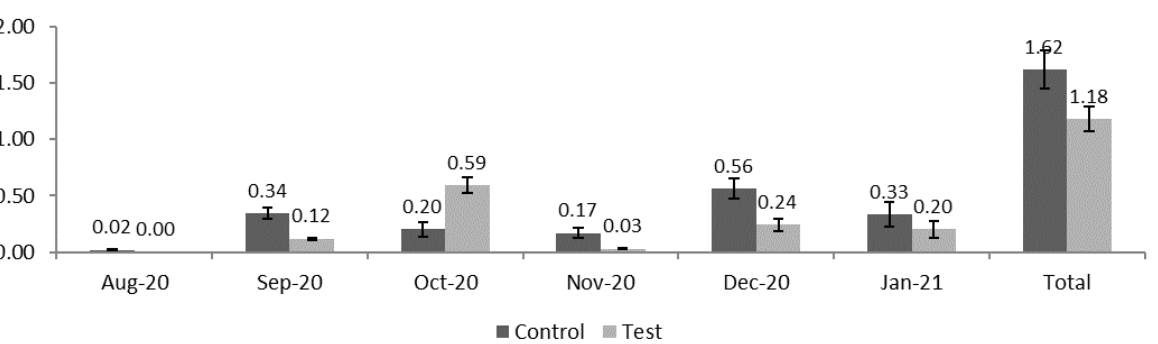
Figure 5. Non marketable yield (kg/m 2 ) per experimental piece per month .